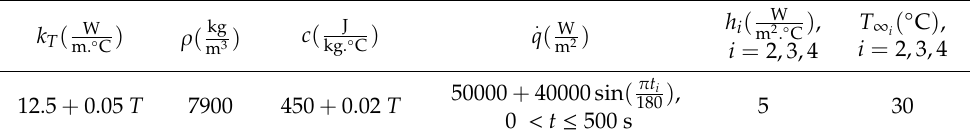
Table 1. Data used for the heat conduction